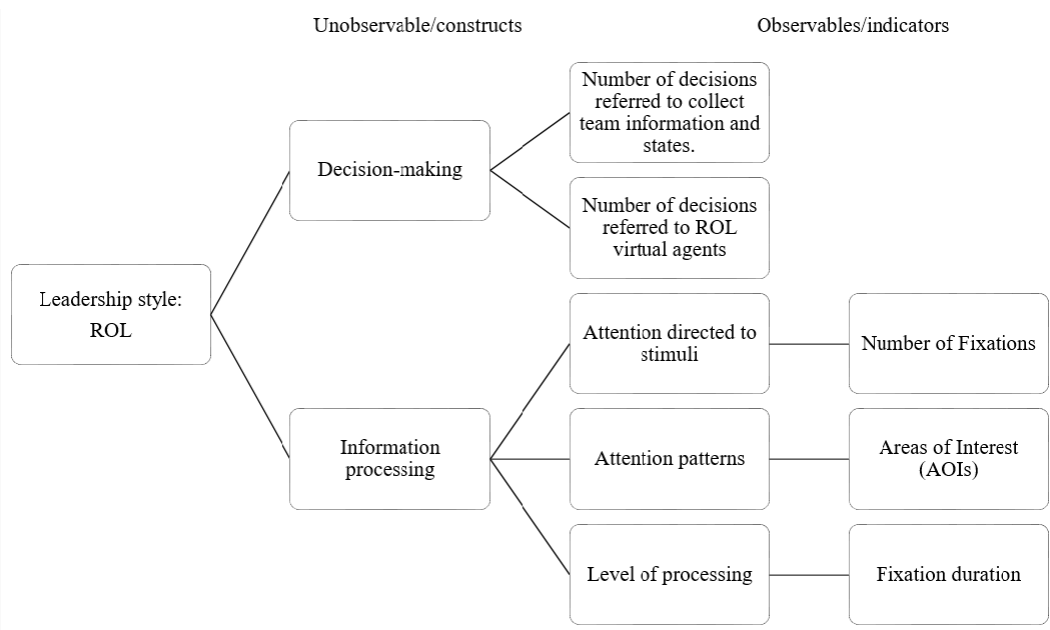
Figure A12. ROL competency model.